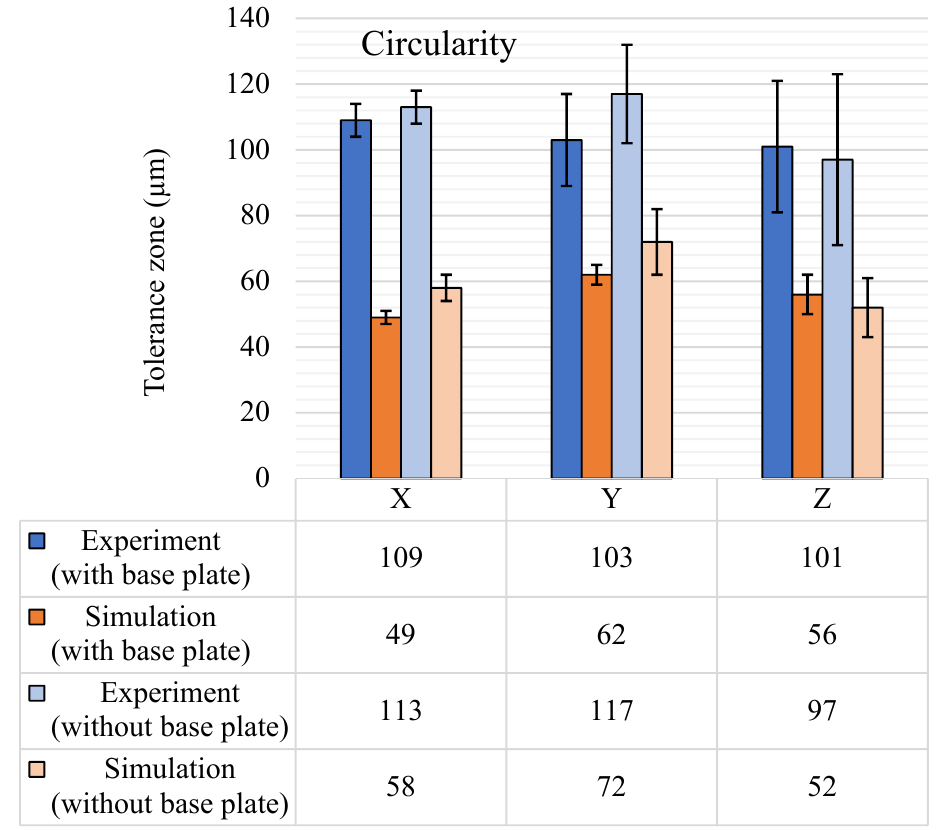
Figure 9. Circularity ( µ m) tolerance results, with and without the base plate.